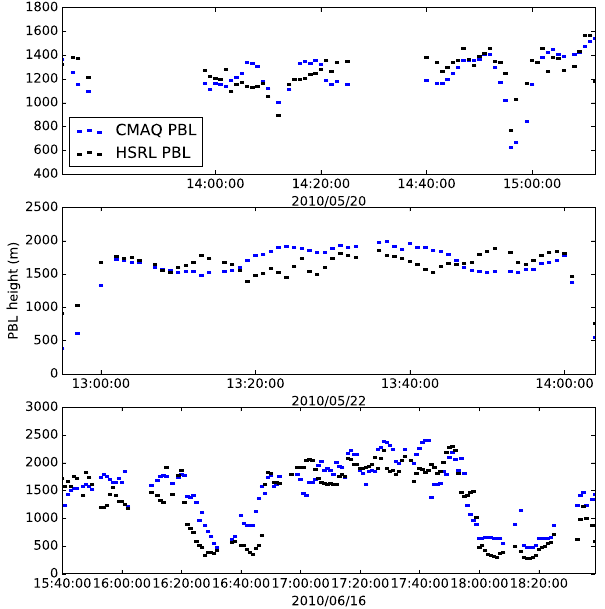
Figure 5. Time series of WRF predicted planetary boundary layer heights and HSRL calculated mixed layer heights for three flight sections in the San Joaquin Valley (two during CalNex and one dur- ing a CARES